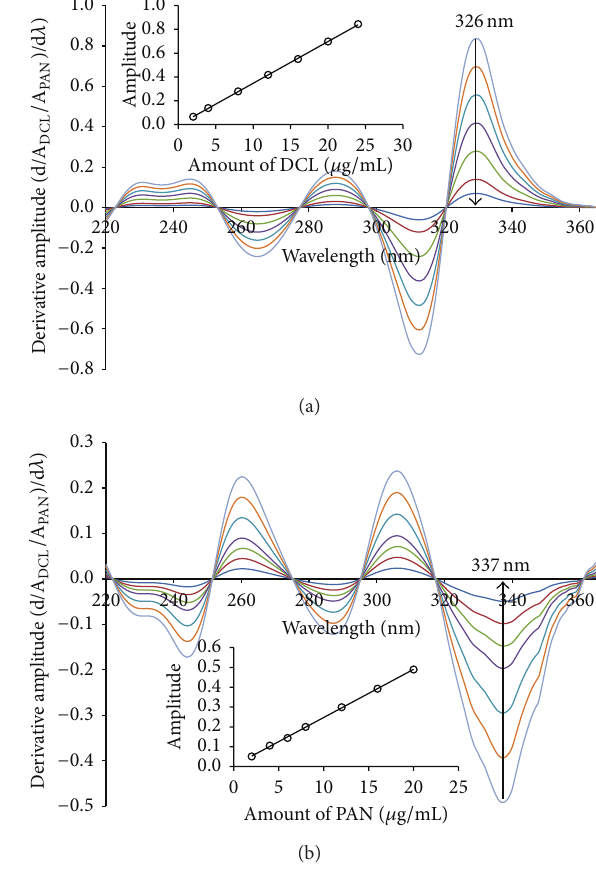
Figure 4: (a) Division spectra of 2.0–20.0 𝜇 g/mL pantoprazole and (b) division spectra of a standard solution and a mixture solution containingthesameconcentrationofpantoprazole,using4.0 𝜇 g/mL diclofenac as a divisor and methanol as a solvent.